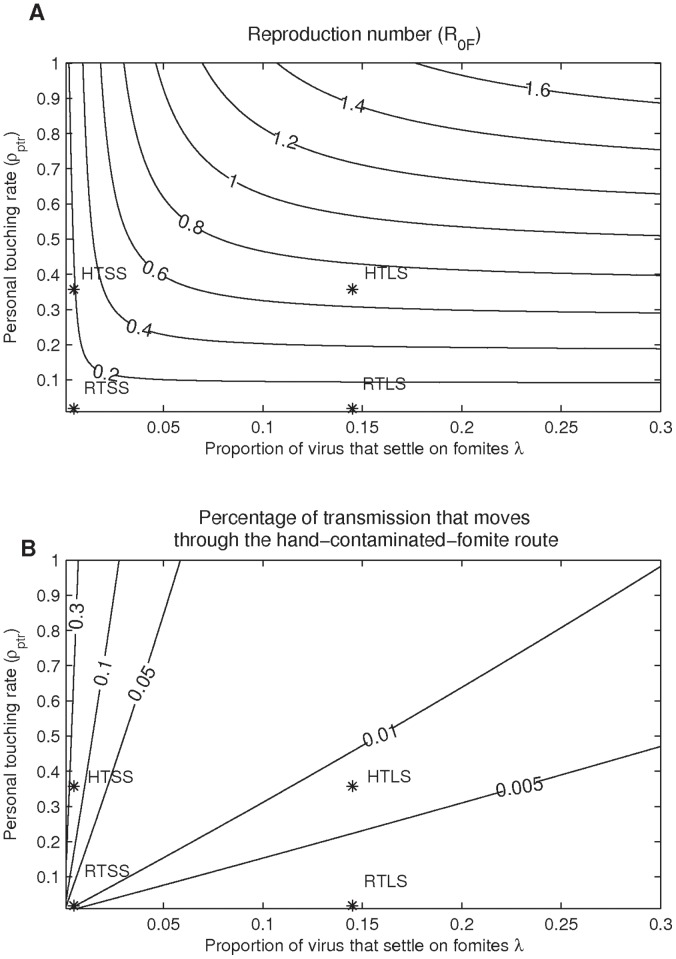
Total transmission potential and the percentage of transmission through hand-contaminated-fomite route.A) total transmission potential (Reproduction number); B) the percentage of transmission through hand-contaminated-fomite route (R0_hF/R0F) as functions of the proportion of virus that settle on fomites (λ) and the personal touching rate (ρptr). Stars in the figures are the cases when the parameters take on values in Tables 1 and 2. Changes in ρptr have more impact on the fomite transmission when ρptr is low than when ρptr is high.